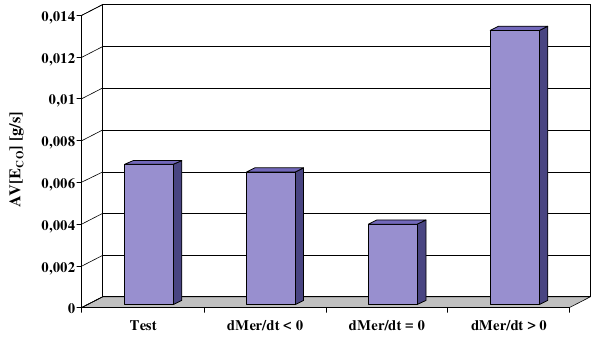
Fig. 19. The average value of the nitrogen oxides emission in the NEDC test and in the states corresponding to the negative, zero and positive time derivative values of the engine speed